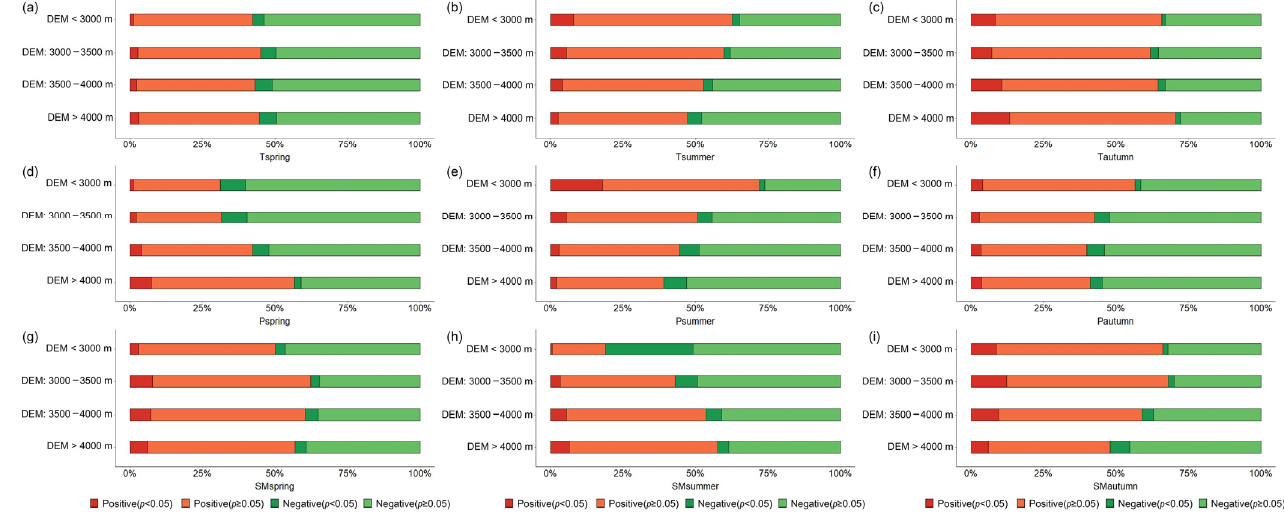
Figure 7. Percentages of correlation between EOS and different driving factors at different elevation zones. The driving factors were ( a , b , c ) seasonal temperature (Tspring, Tsummer, and Tautumn are spring, summer, and autumn temperature, respectively), ( d , e , f ) seasonal precipitation (Pspring, Psummer, and Pautumn are spring, summer, and autumn precipitation, respectively), and ( g , h , i ) seasonal soil moisture (SMspring, SMsummer, and SMautumn are spring, summer, and autumn soil moisture,